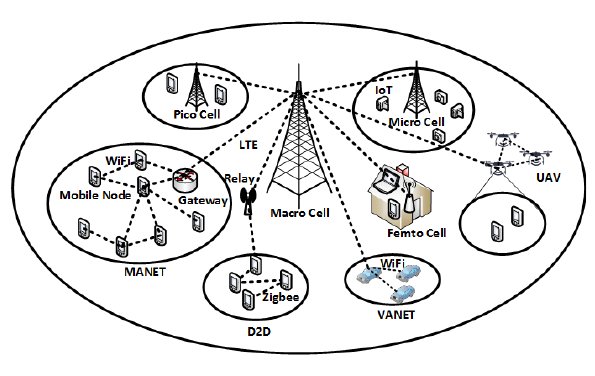
Figure 1. System Model of Typical Heterogeneous Networks